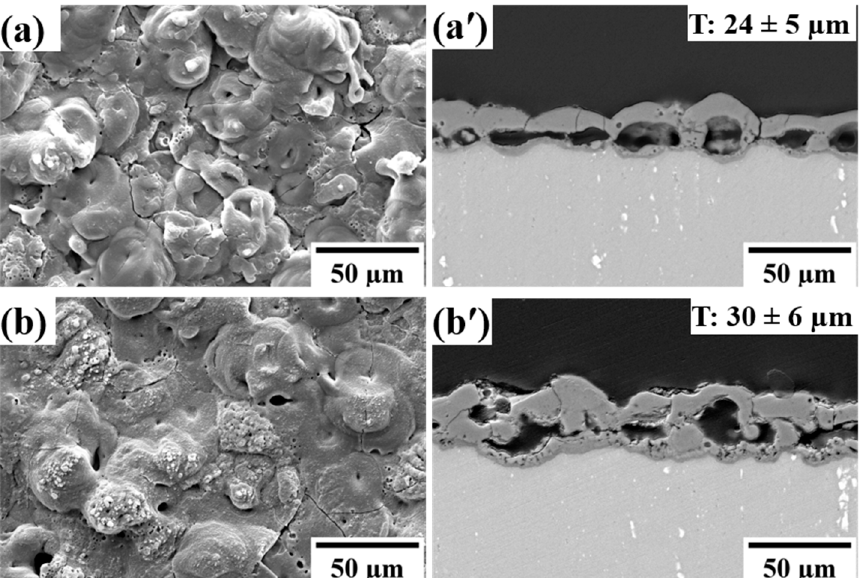
Figure 3. SEM images of surfaces and cross-sections of the PEO coated specimens: ( a , a ′ )-S3K1, ( b , b ′ )-S3K3. Inserted values in the cross-section images are thickness, T.